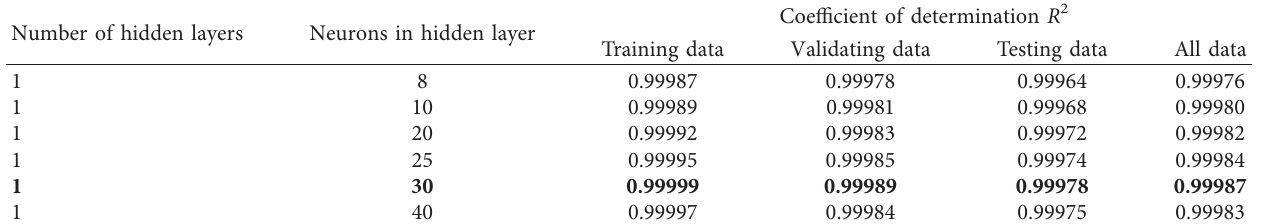
Table 4: Determination coefficient R 2 for different learning algorithms to predict deflection for Scheme A.